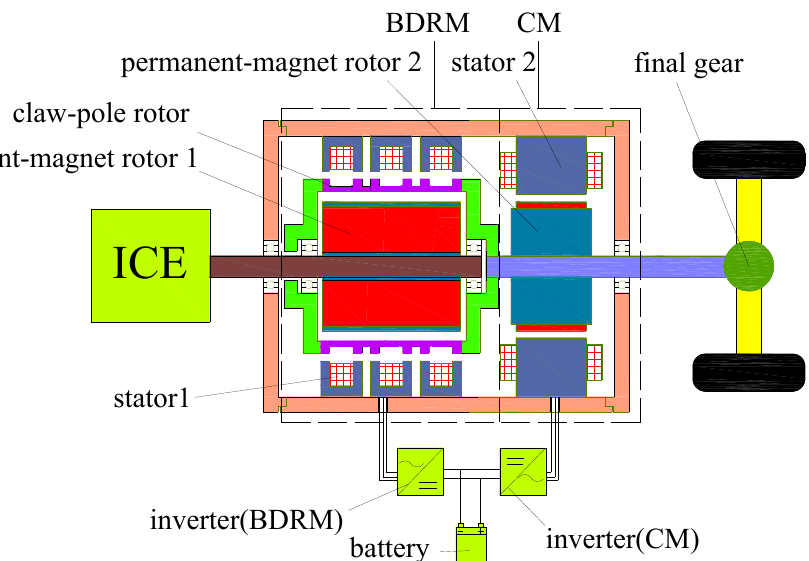
Figure 1. Novel brushless CS-PMSM